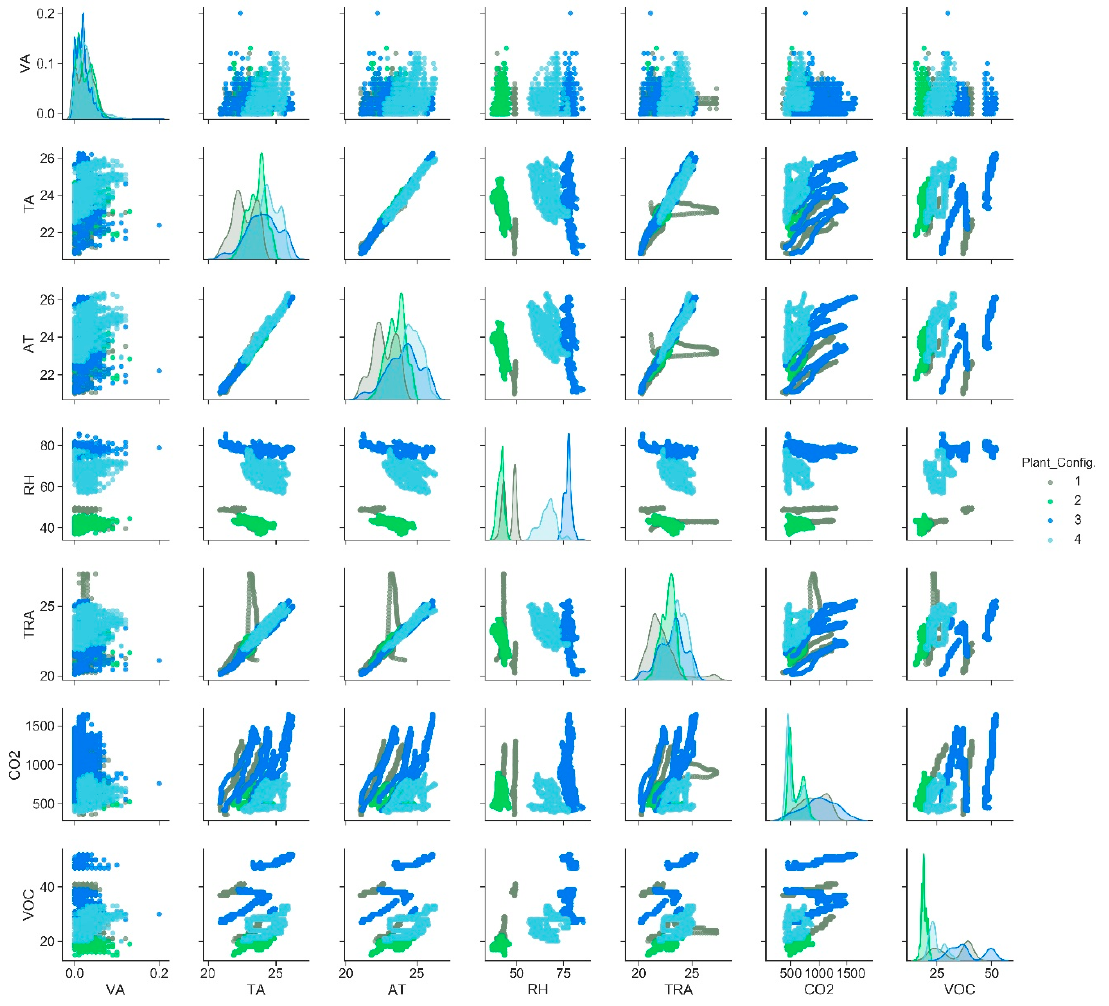
Figure 5. Correlation matrix between environmental parameters.